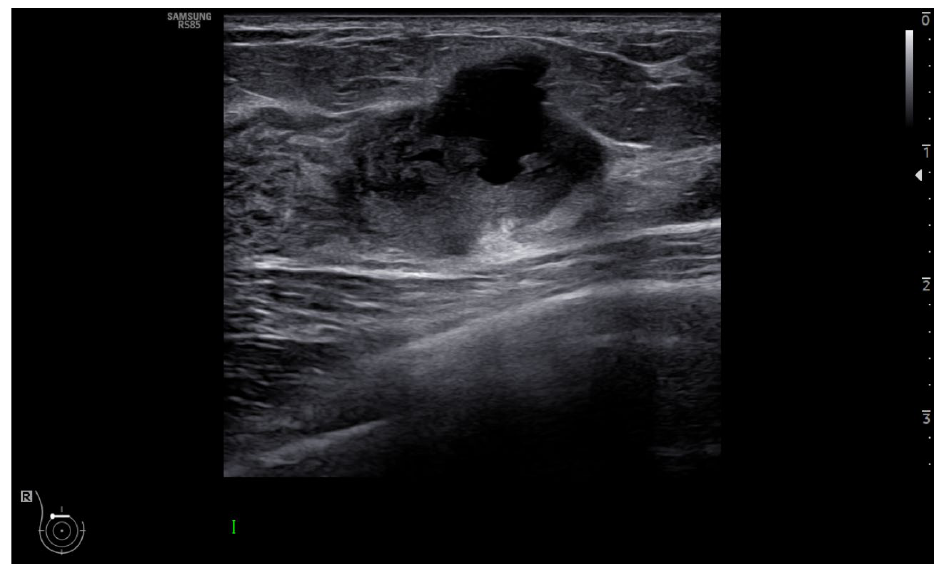
Figure 2. Ultrasound shows a heterogeneous hypoechoic mass lesion with small lobulations located in the upper quadrant of the left breast, highly suspicious for breast cancer.